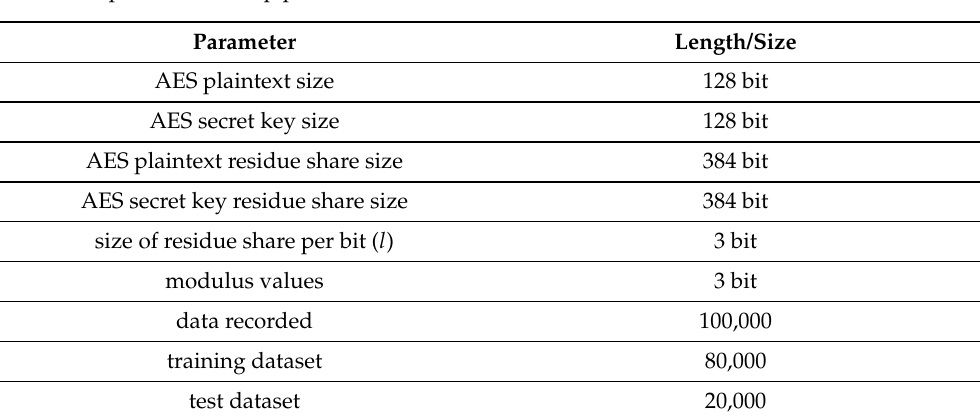
Table 9. Experimental setup